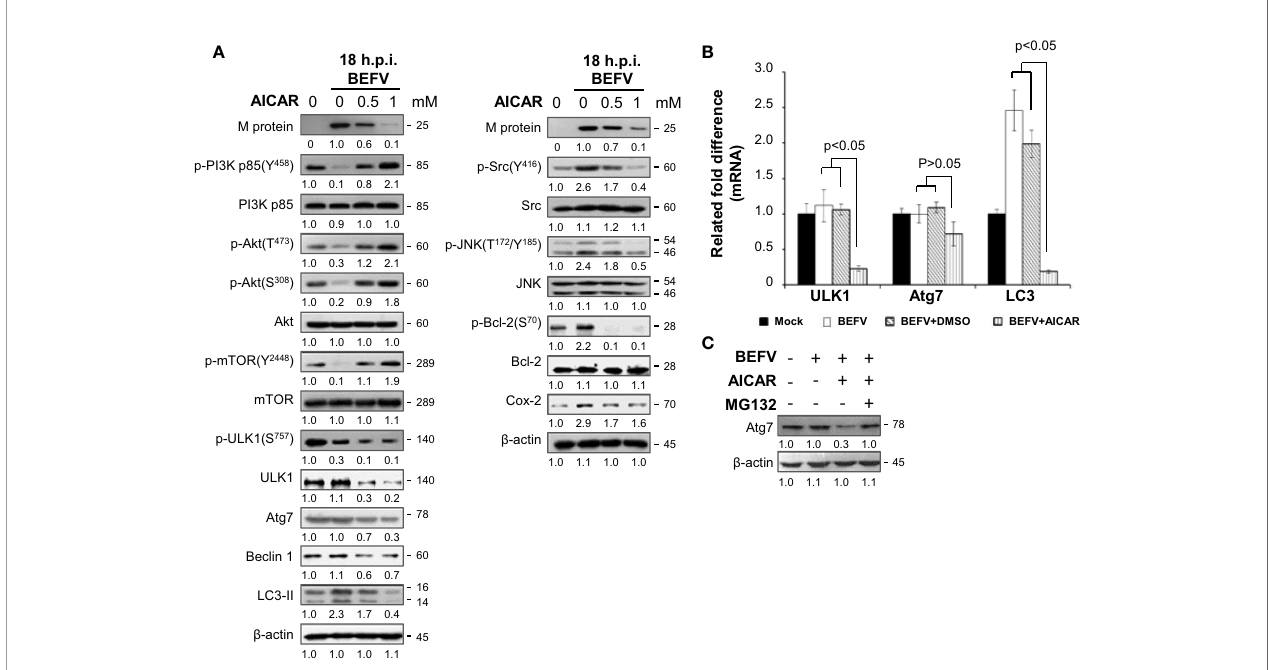
FIGURE 5 | BEFV induces downregulation of the PI3K/Akt/mTOR pathway and autophagy in the late stage, suppressed by 5-aminoimidazole-4-carboxamide-1- b - riboside (AICAR). (A) MDBK cells were pretreated with or without AICAR (0.5 and 1 mM), respectively, for 30 min, followed by infection with BEFV at an MOI of 1 for 18 h. The cell lysate was collected and subjected to immunoblotting with the respective antibodies as indicated. (B) Total cellular RNA of BEFV-infected MDBK cells was extracted, transcribed into cDNA, and subjected to real-time qRT-PCR. The mRNA levels of ULK1, Atg7, and LC3 were normalized to that of GAPDH. The mRNA levels in mock-treated cells was considered 100%. All data obtained in this study were analyzed by student t-test and expressed as averages of three independent experiments. P values of less than 0.05 were considered signi fi cant. (C) MDBK cells were pretreated with AICAR alone or in combination with MG132 (5 mM) for 30 min, followed by infection with BEFV at an MOI of 1 for 18 h. Cell lysates were collected and subjected to immunoblotting with the antibody speci fi c to Atg7. The levels of indicated proteins in the mock group (A, C) were considered onefold. The activation and inactivation folds indicated below each lane were normalized against values for the mock control group. Protein levels were normalized to those for b ‐ actin. Signals in all Western blots were quanti fi ed with ImageJ software. All experiments were conducted in three independent experiments. The predicted size of each protein was labeled at the right-hand side in